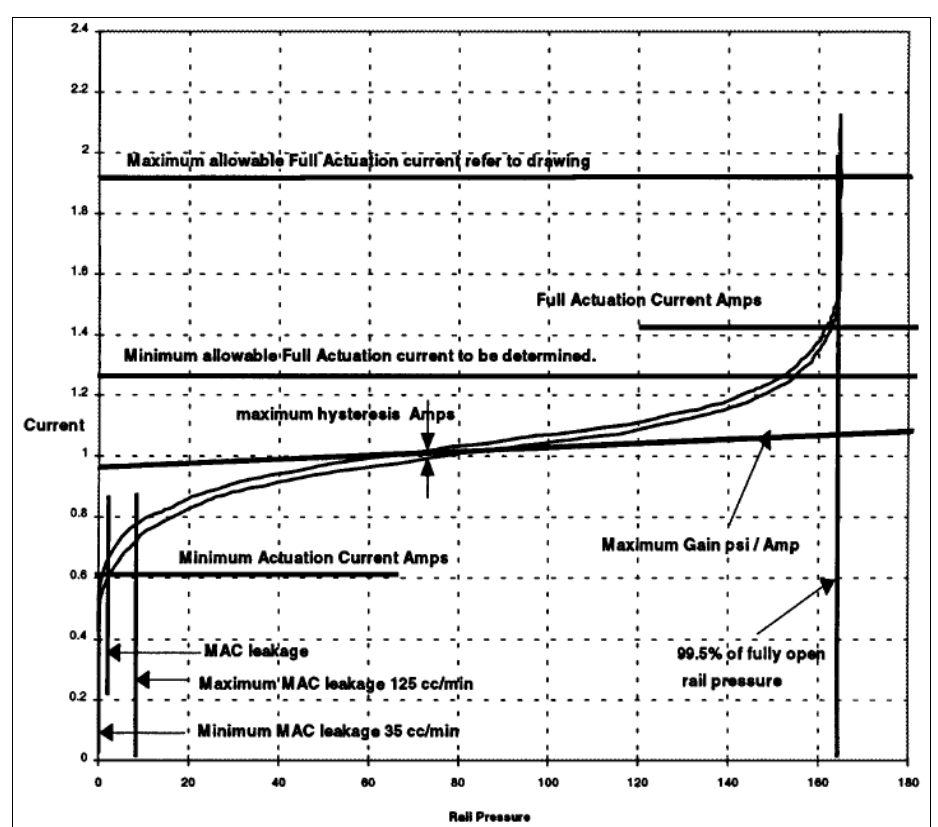
Figure 2. EFC valve actuation current profile with respect to desired rail